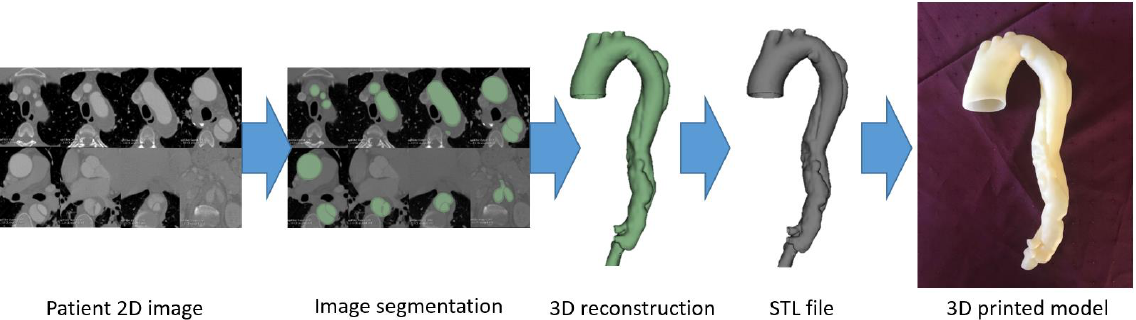
Figure 3. Steps involved in the generation of a 3D-printed aortic dissection model using 3D Slicer. STL — standard tessellation language. Reprinted with permission under the open access from Wu et al. [34].